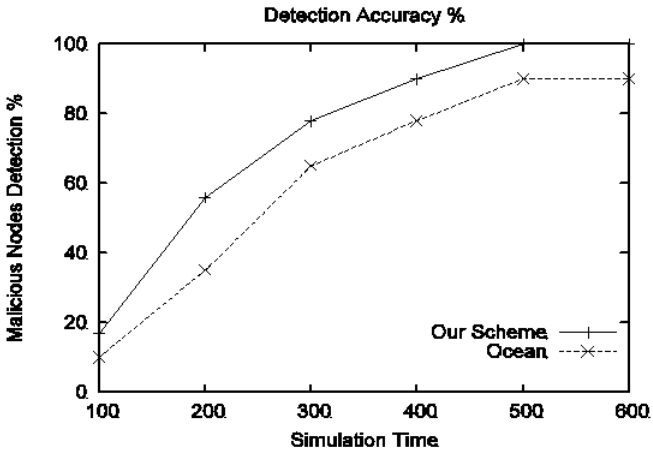
Figure 8. Performance comparison of the proposed scheme and OCEAN in terms of detection accuracy in the presence of type-I attackers.